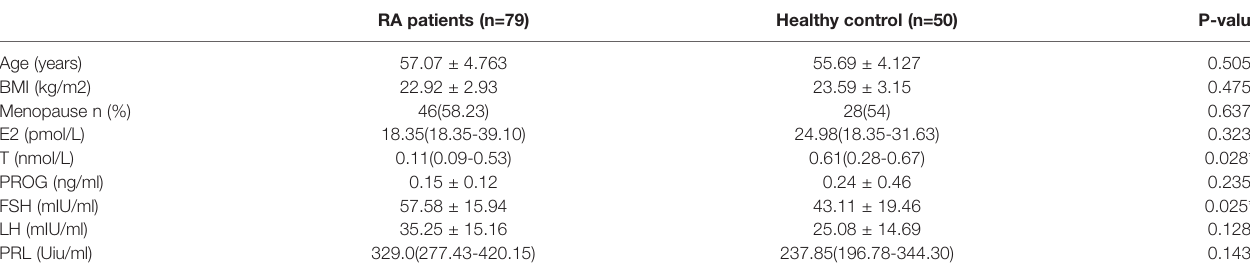
TABLE 1 | Sex hormone levels in RA patients and healthy controls.